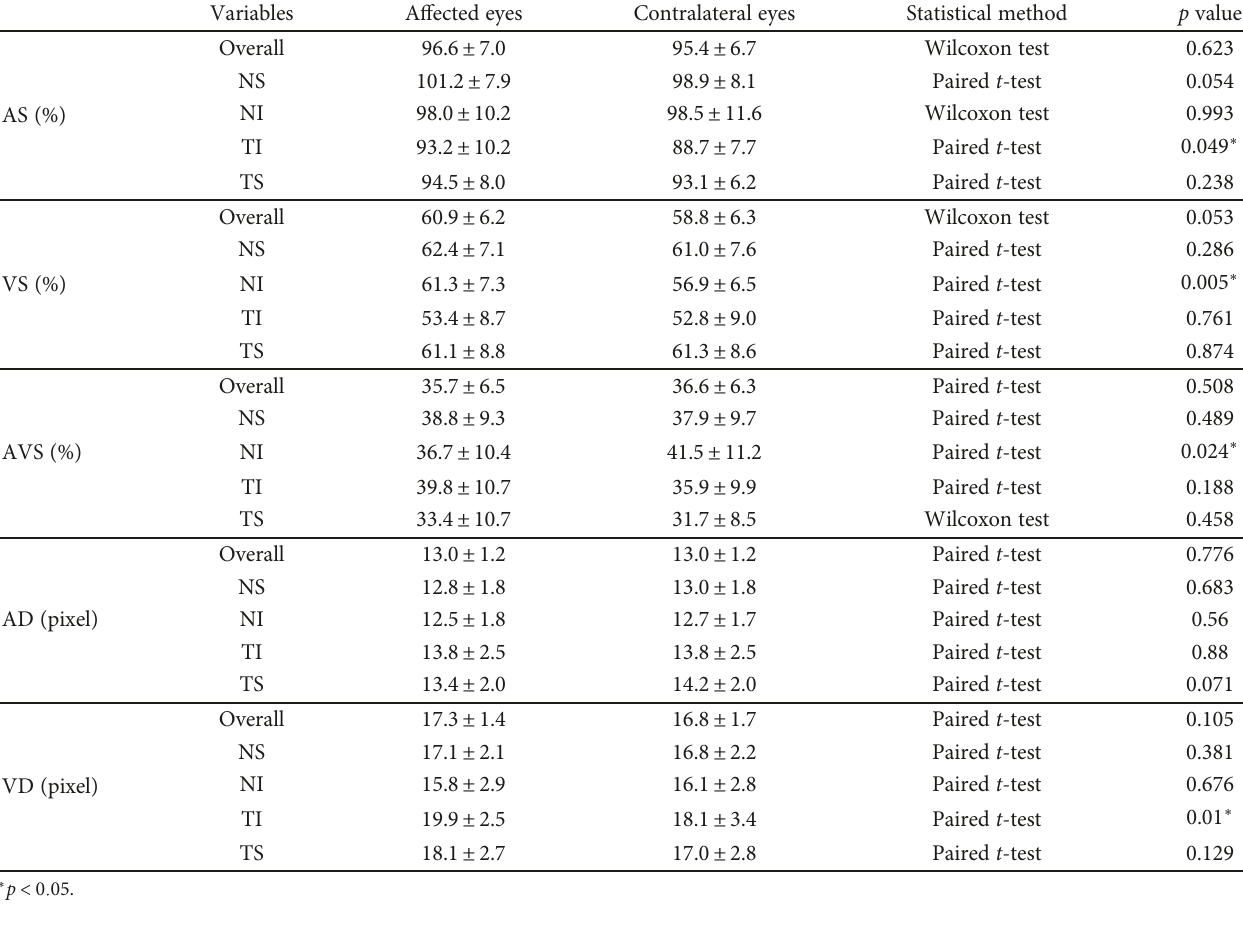
Table 2: Comparison between a ff ected eyes and contralateral eyes.